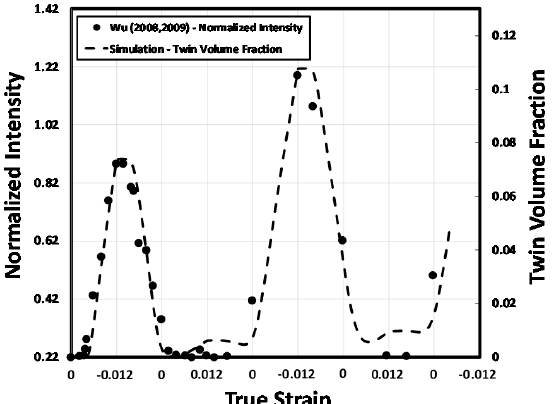
Figure 15. The variation of predicted twin volume versus the strain compared to the experimentally measured change in the normalized intensity of the { 0002 } diffraction peak along the longitudinal direction obtained by Wu et al. [35] and Wu [107] in ZK60A Mg alloy during the cyclic loading along the extrusion direction (After Yaghoobi et al. [9]).